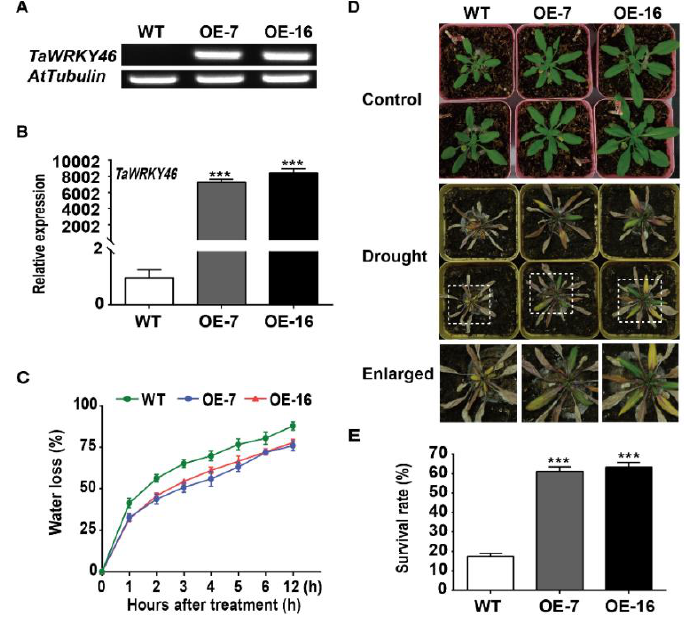
Figure 5. The phenotype and tolerance assay of TaWRKY46 -overexpressing Arabidopsis after drought treatment. Gene validation of TaWRKY46 in transgenic Arabidopsis lines by PCR ( A ) and qRT-PCR ( B ). ( C ) The water loss rate of the detached leaves. ( D ) The phenotype of TaWRKY46 -overexpressing Arabidopsis plants after water withholding for 25 days. ( E ) The survival rate of TaWRKY46 -overexpressing Arabidopsis plants after drought treatment. Asterisks indicate a significant difference between wild-type (WT) and transgenic Arabidopsis lines (*** p < 0.001).